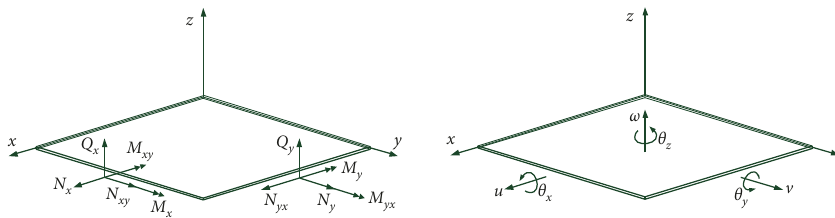
Figure 5: Internal force and displacement of the flat unit.